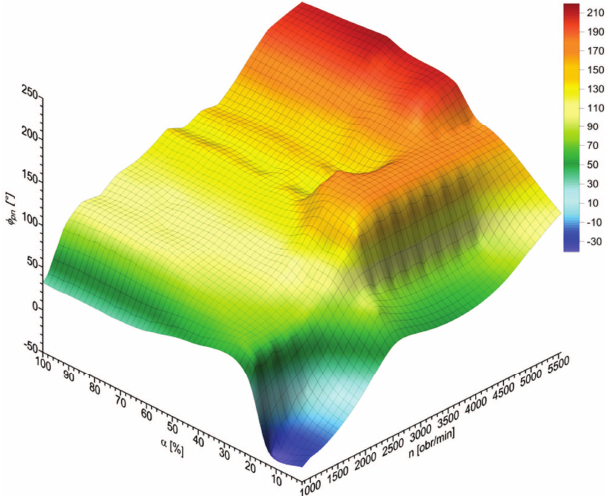
Fig. 3. „Map” of fill survey phase